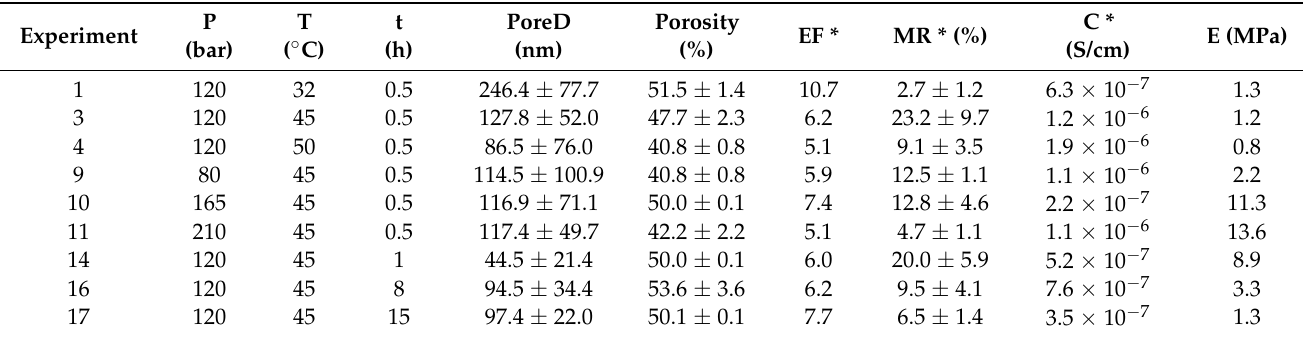
Table 4. Summary of the data, including Young’s modulus, that corresponds to the scaffolds obtained from specific